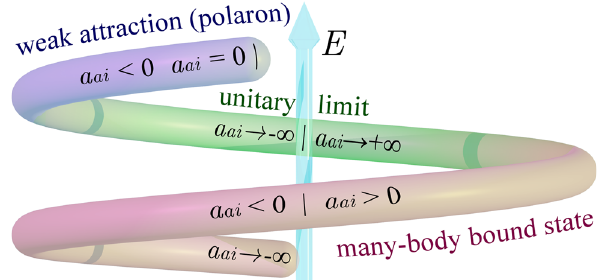
Fig. 1 Schematic phase diagram. A schematic phase diagram showing various regimes for a single ion immersed in a dilute Bose gas upon changing the atom – ion scattering length and the number of the two-body bound states. The vertical axis indicates the change of the ion energy E as the value of atom – ion s -wave scattering length a ai is varied. The spiral refers to a continuous change of the energy leading to realization of different physical regimes as the value of a ai is cyclically changed from minus to plus in fi nity. Departing from the non-interacting case a ai = 0, with zero ion energy, E = 0, and by making the ion attraction stronger the following regimes are observed. A weak attraction leads to the polaronic regime where the ion can be described in terms of a quasiparticle. Such a description is no longer possible in the unitary regime marked by a diverging s -wave scattering length. The unitary point, ∣ a ai ∣ = ∞ , is the threshold value for the formation of an ion-atom two-body bound state. For stronger atom – ion attraction many-body bound state is formed in which a large number of atoms is effectively trapped by the ion.